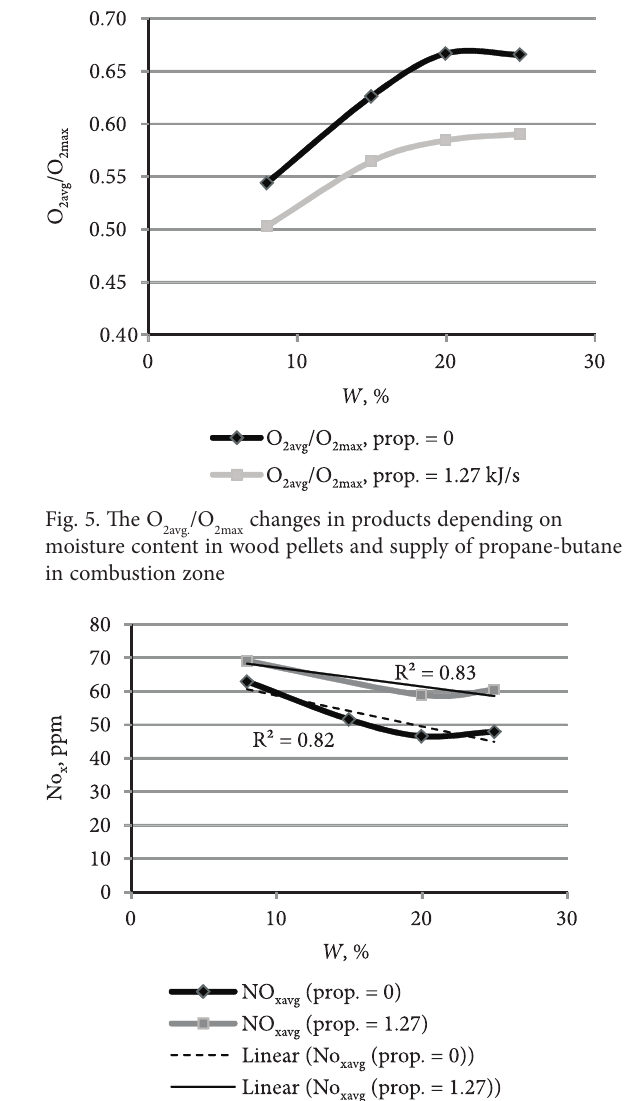
Fig. 6. The NO /NO changes in products depending on xavg. xmax moisture content in wood pellets and supply of propane-butane in combustion